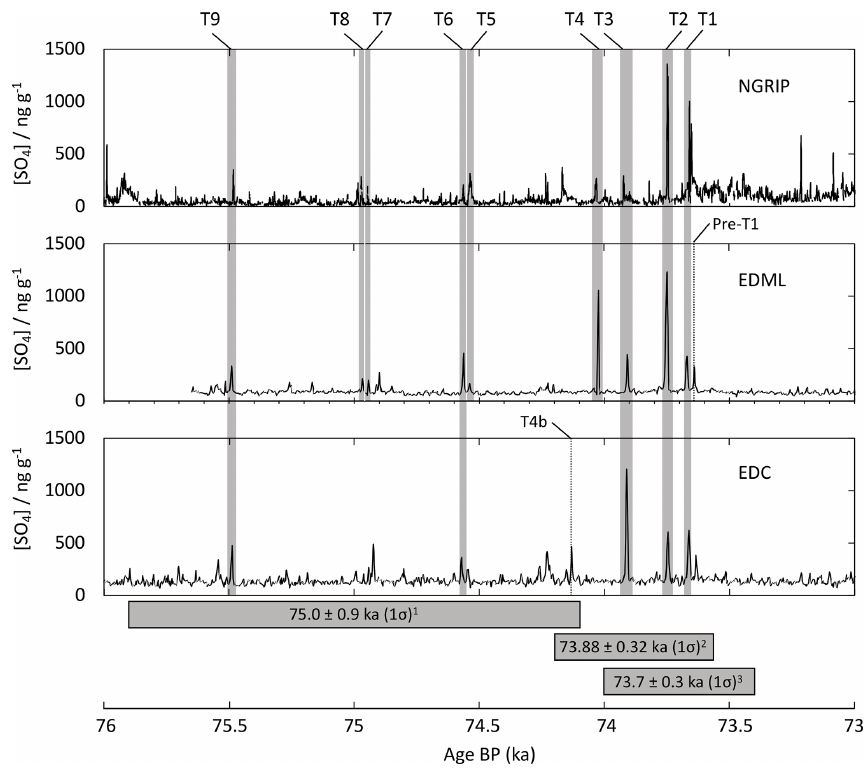
Figure 1. Toba candidates identified in both Greenland (NGRIP) and Antarctic (EDML, EDC) ice cores by Svensson et al. (2013). Sulfate concentration data from Svensson et al. (2013) [NGRIP and EDML] and Sparks et al. (2021) [EDC]. The AICC2012 ice core chronology (Bazin et al., 2013; Veres et al., 2013) was applied to both Greenland and Antarctic ice cores. Dotted lines indicate the additional peaks measured in EDC and EDML. The age estimates for the Toba eruption from (1) Mark et al. (2014), (2) Storey et al. (2012), and (3) Mark et al. (2017) are represented by horizontal bars indicating 1 σ for each date. Note that the stated uncertainty in AICC2012 dates at this period is around 1500